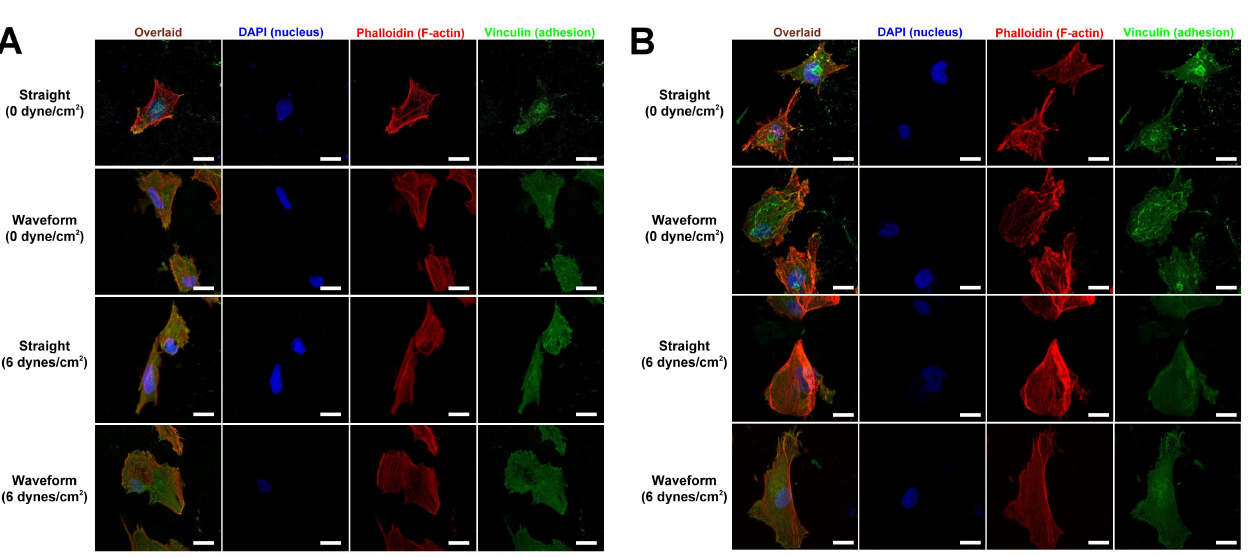
Figure 4. Morphology and adhesion patterns of PDL cells on the microfibers at ( A ) 1 h and ( B ) 4 h after initial seeding. Scale bar: 20 µ m.